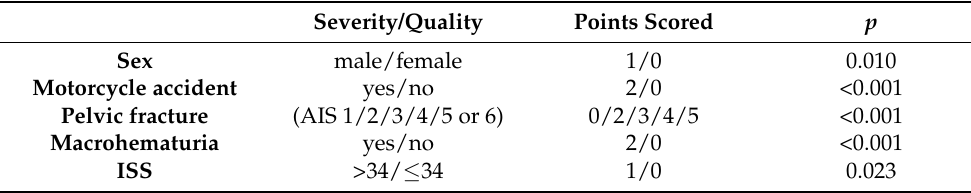
Table 3. The UPPS Score — introducing a novel scoring system.